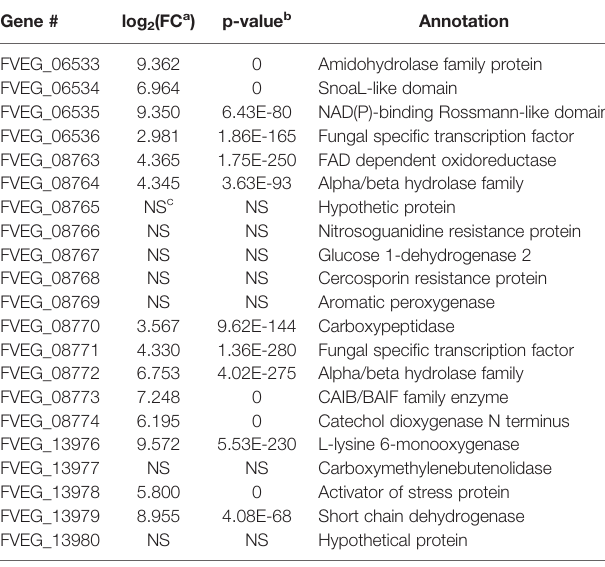
TABLE 2 | Gene clusters with differential expression upon exposure to 2-oxindole